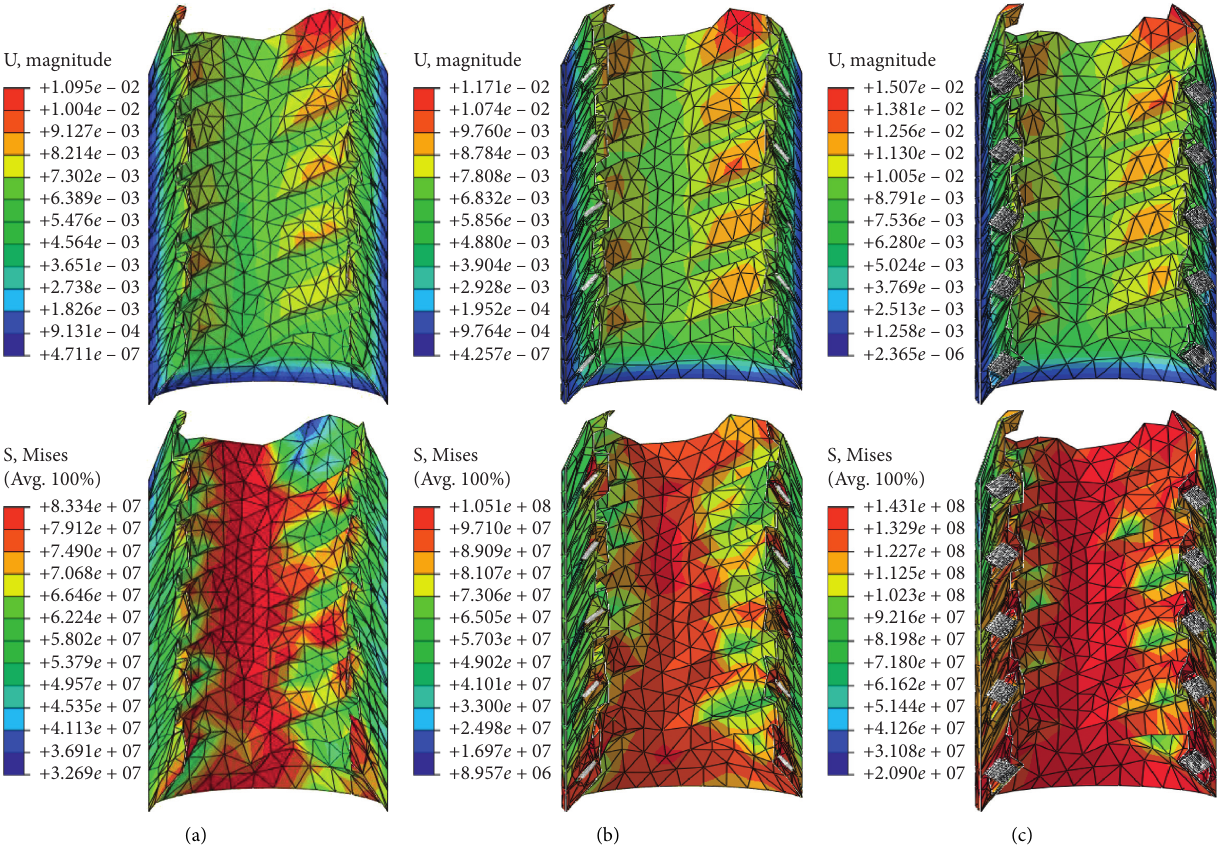
Figure 8: The peak stress and corresponding displacement of three types resin grout: (a) pure resin grout, (b) resin grout with 0.6mm diameter steel segment, and (c) resin grout with 3mm diameter steel